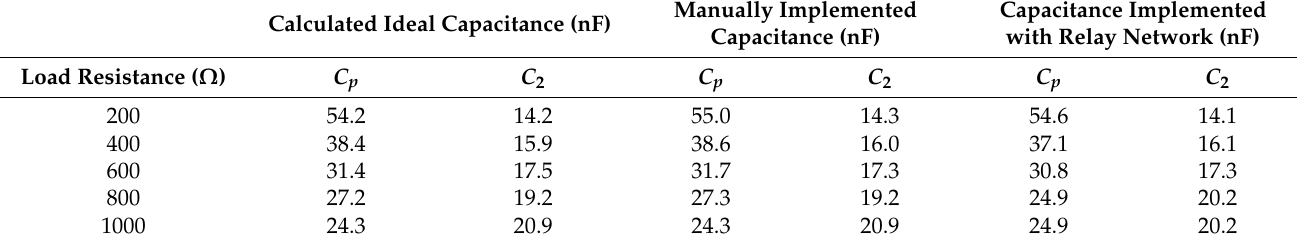
Figure 10. Proposed reconfigurable WPT system in this work. Table 1. Capacitance of C 2 and C p used in this